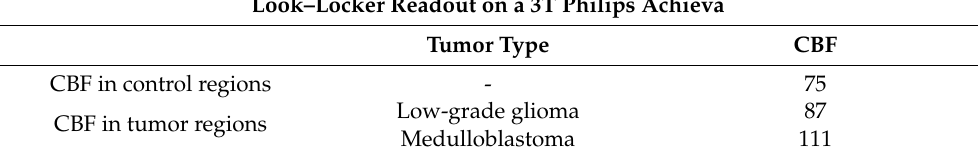
Table 6. Absolute CBF values (mL/100 g/min) within both tumor and healthy tissue regions of interest [17]. Imaging Technique: Spin Tagging with Alternating RF Labeling Scheme (STAR) with a